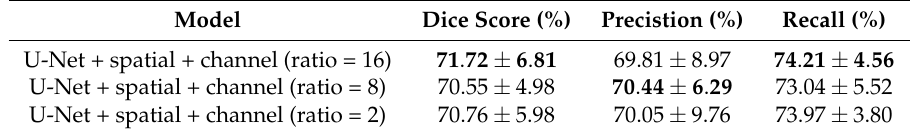
Table 2. Comparison of different channel methods on CVC-ClinicDB dataset (best results marked bold). Model